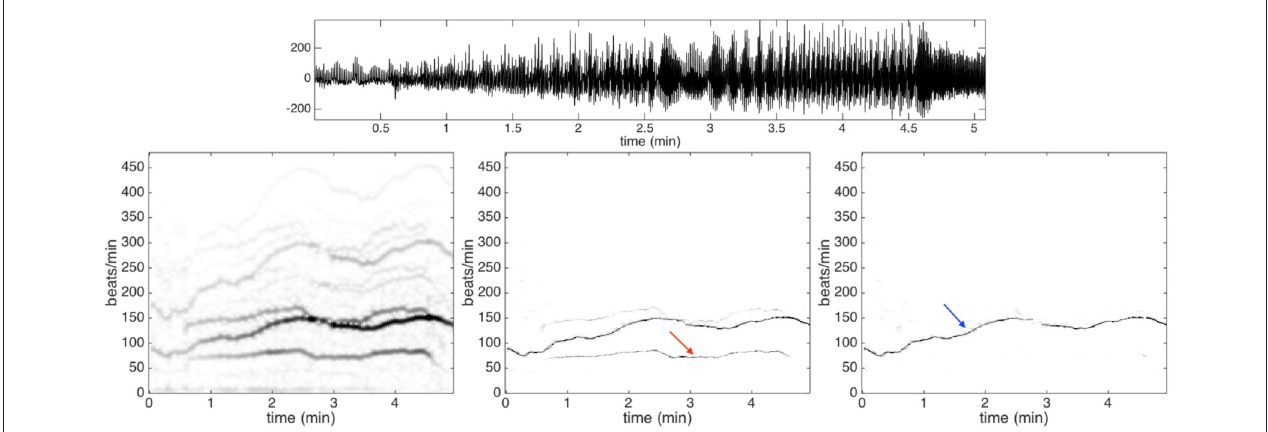
FIGURE 4 | Top row : the photoplethysmography signal of subject 9 in the training dataset of ICASSP 2015 signal processing cup. Second row : the spectrogram is shown on the left panel , the de-shaped spectrogram is shown in the middle panel , and the de-shaped spectrogram with the acceleration offset is shown on the right panel . The dominant curve indicated by the blue arrow in the de-shaped spectrogram with the acceleration offset is the instantaneous heart rate of the subject. On the other hand, the lighter curve indicated by the red arrow in the de-shaped spectrogram is directly related to the body swaying pattern. The heartbeat component displayed in the de-shaped spectrogram follow clearly the running